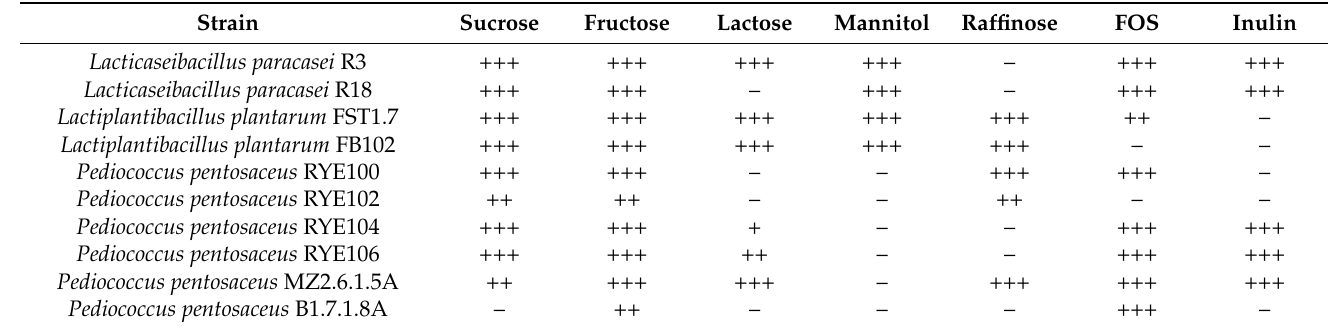
Table 2. FODMAP utilisation profile of selected lactic acid bacteria determined via microtitre FODMAP utilisation assay in mMRS supplemented with either sucrose, fructose, lactose, man- nitol, raffinose, FOS, or inulin (each at 0.5%; w / v ). Growth was measured as optical density (OD) at 595 nm. Strains were incubated at 30 ◦ C for 72 h. Each strain was analysed in triplicate. The mean value of maximum optical density in mMRS supplemented with FODMAP (OD FODMAP ) normalised